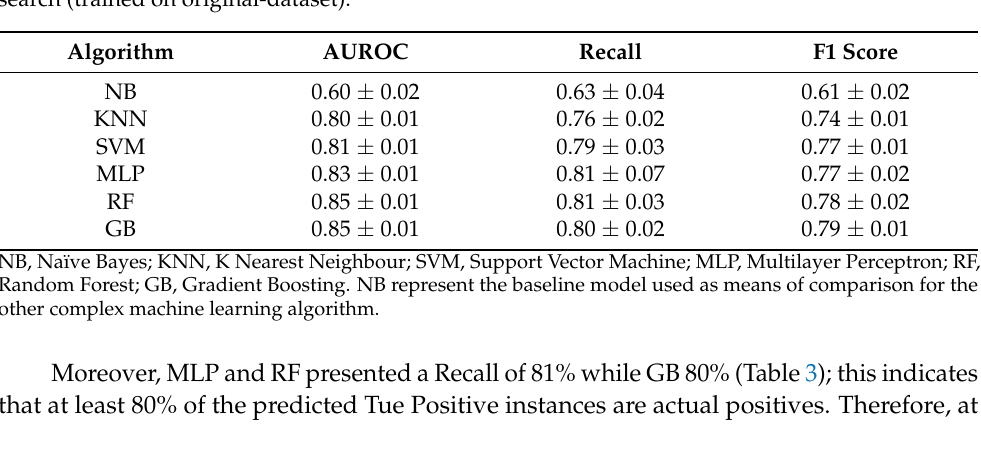
Table 3. Comparison of the predictive performance of the best classifiers obtained from the grid search (trained on